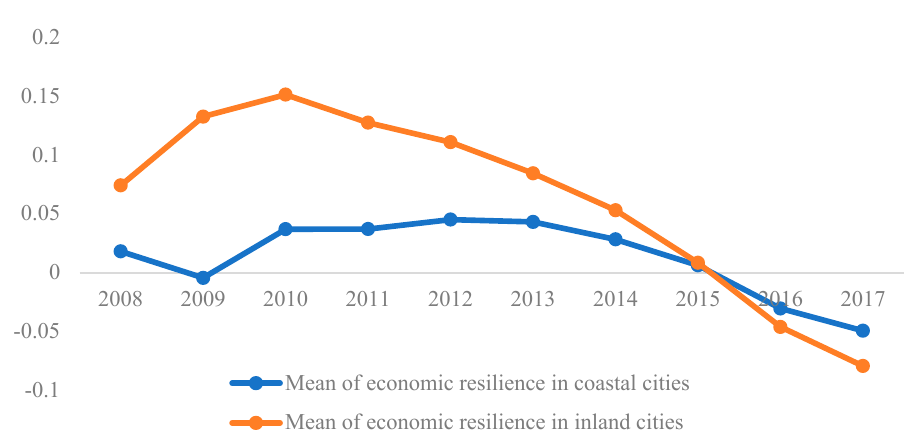
Figure 7. Mean of economic resilience of coastal cities and inland cities.